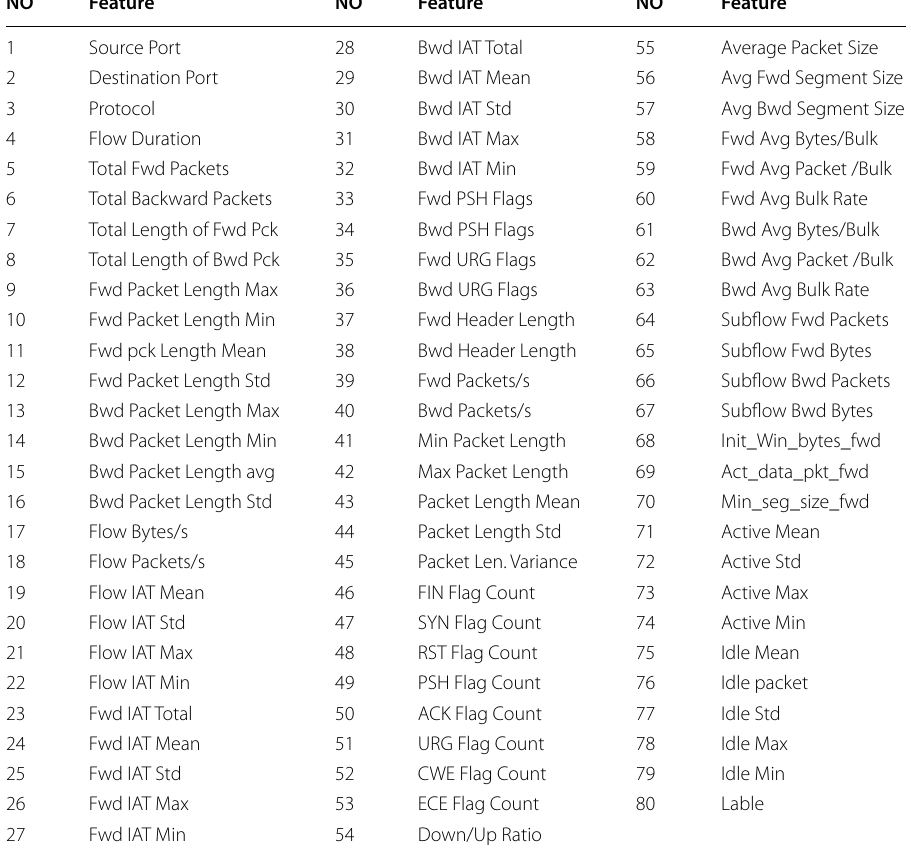
Table 4 Features of CICIDS dataset